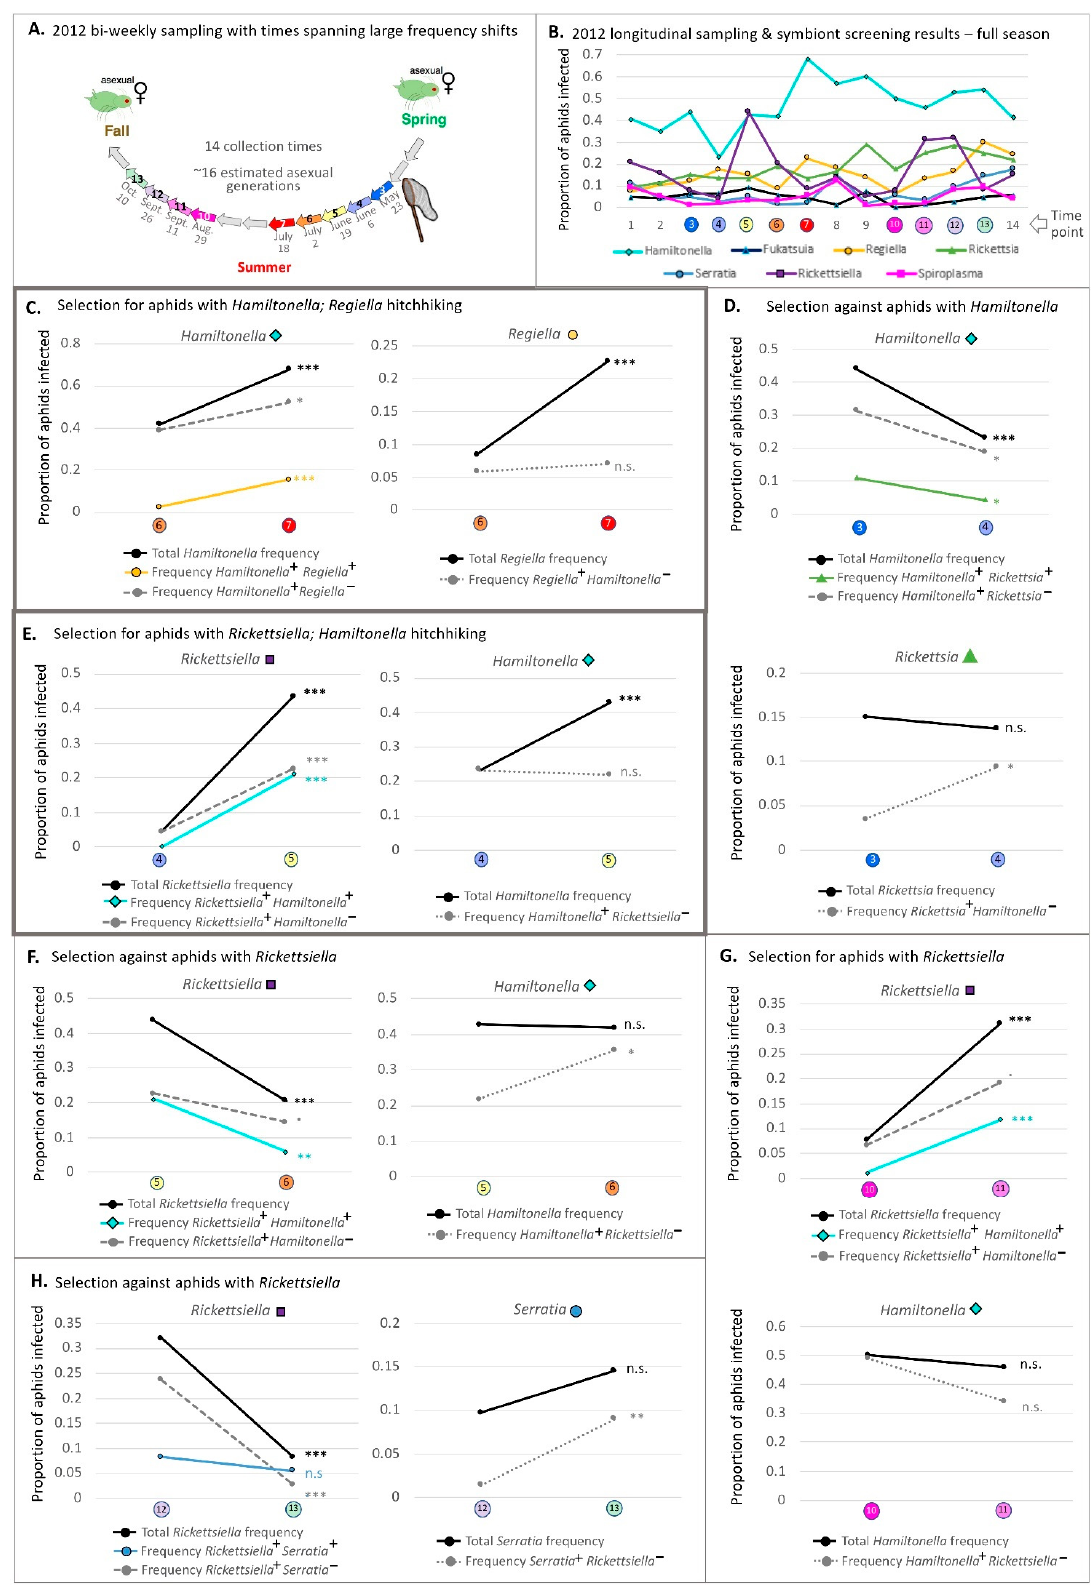
Figure 4. Direct selection vs. hitchhiking effects for Hamiltonella , Rickettsiella , and Regiella across 2-week time intervals in the 2012 field season. We limited our focus to symbionts undergoing frequency shifts ≥ 20% in magnitude across such time intervals. ( A ) Schematic of our 2012 field sampling, with colored arrows emphasizing the time points spanning